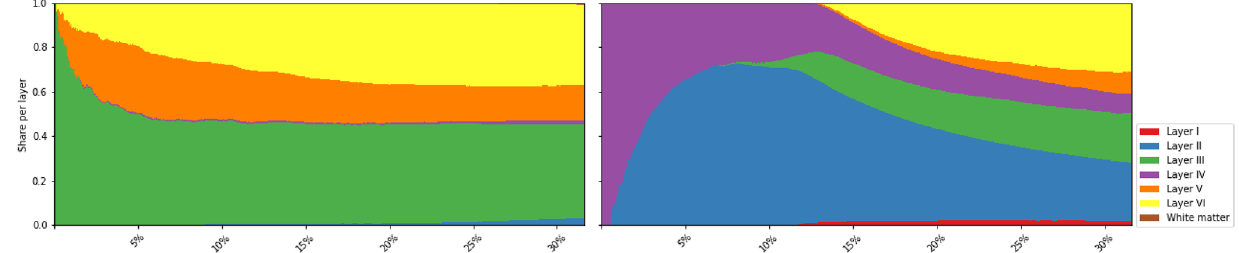
Figure 3. Neuron-centric analysis enables richer statistics. Shown here is the proportion of the top largest (left) and smallest (right) neurons found in the section, distributed per layer. The largest neurons were found in layer III of the cortex and were followed by neurons of layer V and layer VI. Out of the 50 largest neurons, 43 ( 86% ) were found in layer III, 5 ( 10% ) in layer V, and 2 ( 4% ) in layer VI. Out of the 500 largest neurons, 268 ( 54% ) were found in layer III, 142 ( 28% ) in layer V, 87 ( 17% ) in layer VI, and only 3 ( 1% ) in layer IV, which follows neuroanatomical